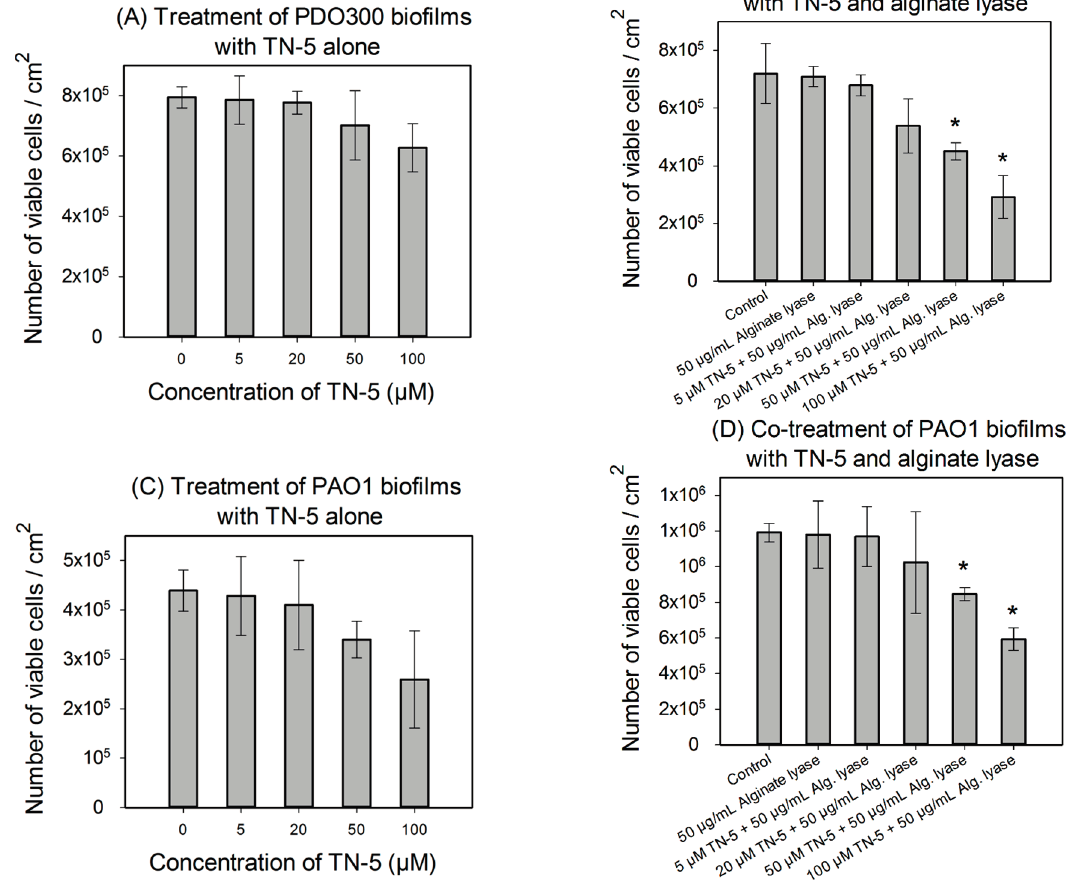
Figure 5. Effects of TN-5 alone and co-treatment with alginate lyase on P. aeruginosa PDO300 ( A and B ) and PAO1 ( C and D ) biofilms. The biofilms were grown for 24 h and treated with TN-5 alone or in combination with alginate lyase for 3.5 h. All